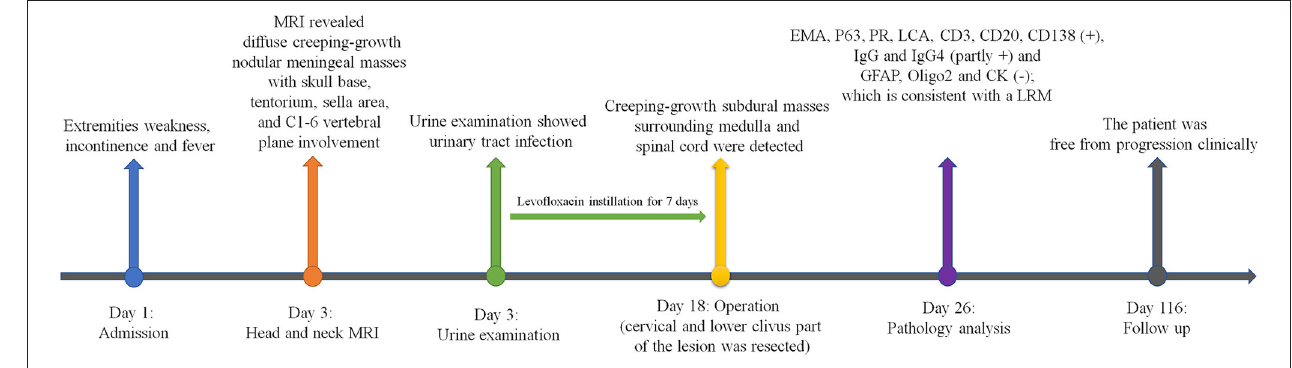
FIGURE 2 | Timeline of the case presentation.